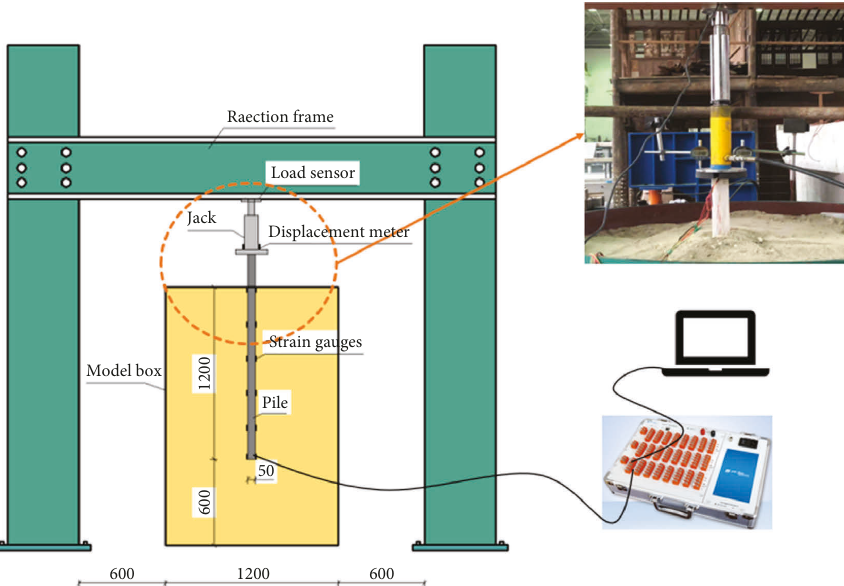
Figure 6: Loading test diagram of model piles (taking 1200mm pile length as an example).